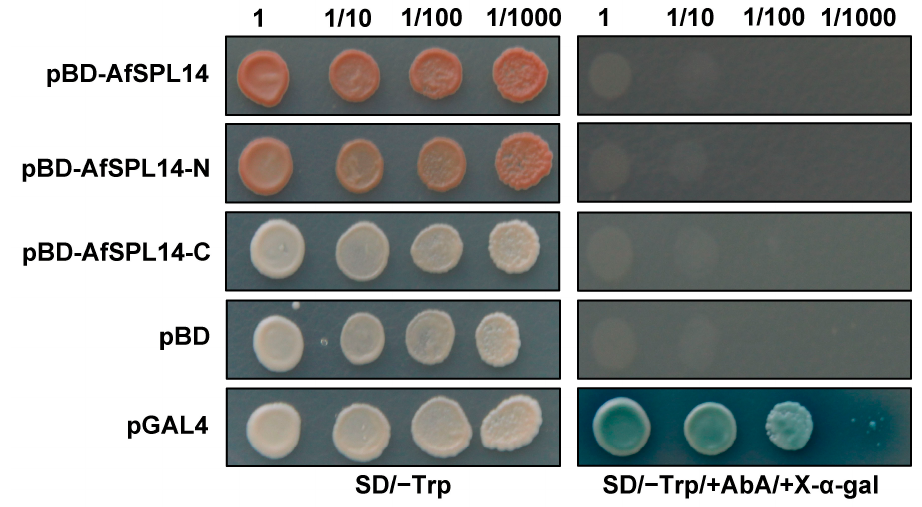
Figure 5. Transactivation activity assay of AfSPL14 in yeast cells. The pGBKT7 (pBD) vectors were fused with the full-length of AfSPL14 (pBD-AfSPL14), the N terminus of AfSPL14 (pBD-AfSPL14-N) and the C terminus of AfSPL14 (pBD-AfSPL14-C), respectively. Each kind of these constructs was then transformed into Y2HGold cells which contained the reporter genes AUR1-C and MEL1 . pBD and pGAL4 plasmids were transformed into Y2HGold cells and used as negative and positive controls, respectively. Yeast clones containing the right constructs grew on SD/ − Trp medium at dilutions of 1, 1/10, 1, 100, and 1/1000 for three to five days, and were then transferred onto SD/ − Trp/+AbA/+X- α -Gal medium for continuous growth for three further days to test their transactivation activities. SD: synthetic dropout; AbA: Aureobasidin A; SD/ − Trp: SD medium without Trp; SD/ − Trp/+AbA/+X- α -gal: SD medium without Trp, but with 40 mg/L X- α -gal and 200 µ g/L